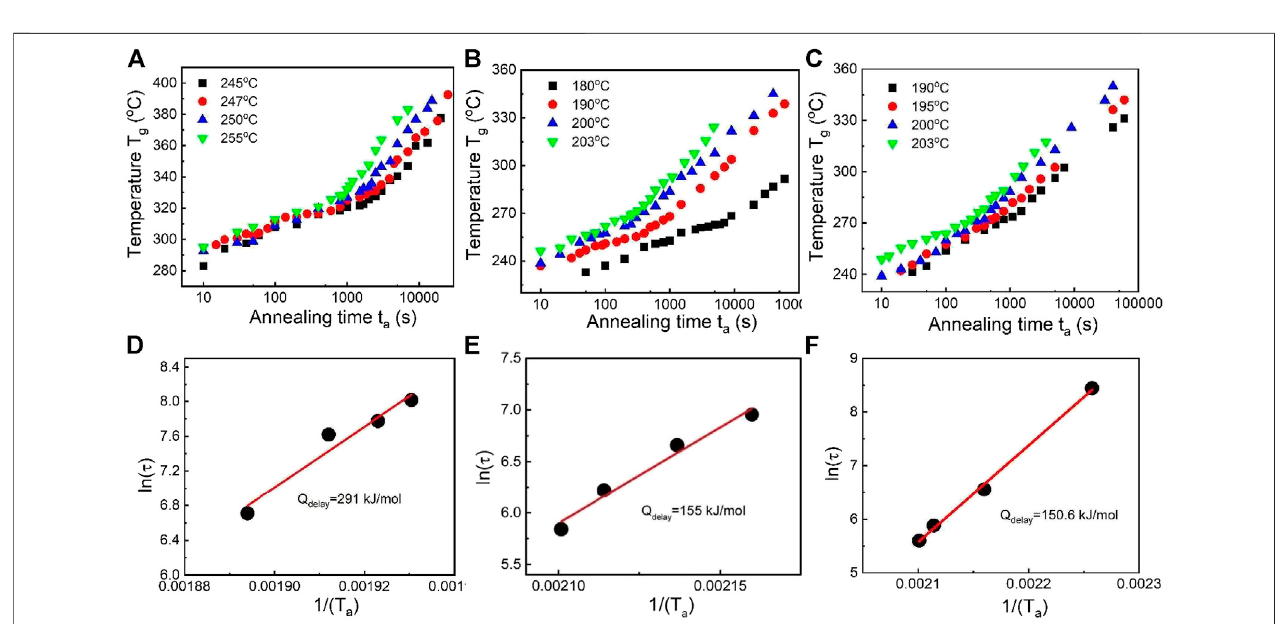
FIGURE 7 | Tg vs. logta plot for Cu-doping Al 88 Y 7 Fe 5 systems at different Ta: (A) Al 87 Y 7 Fe 5 Cu1, (B) Al 88 Y 6 Fe 5 Cu 1 , (C) Al 88 Y 7 Fe 4 Cu 1 . Delay time activation energy (cid:3) for (D) Al Qdelay by fi tting the Equation of τ (cid:2) τ 0 exp (cid:1) Q 87 Y 7 Fe 5 Cu 1 ; (E) Al 88 Y 6 Fe 5 Cu 1 ; (F) Al 88 Y 7 Fe 4 Cu 1 . (from Gao et al. (2019)). RT